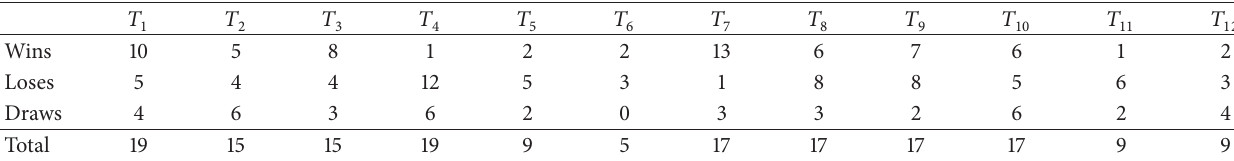
Table 2: Numbers of wins, loses, and draws.